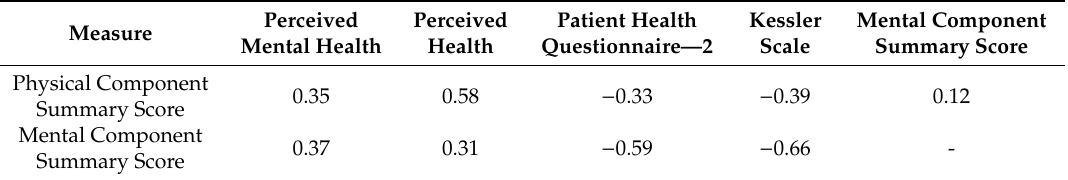
Table 2. Spearman rank correlation coe ffi cients for construct (convergent and discriminant) validity of Physical Component Summary Score and Mental Component Summary Score in the Short-Form 12-Item Survey—version2 among an older (65 years or greater) US population 1 .